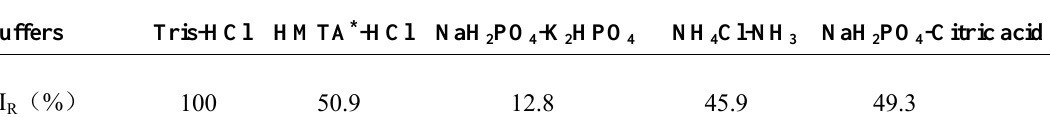
Table 1 . The choice of buffer solutions.